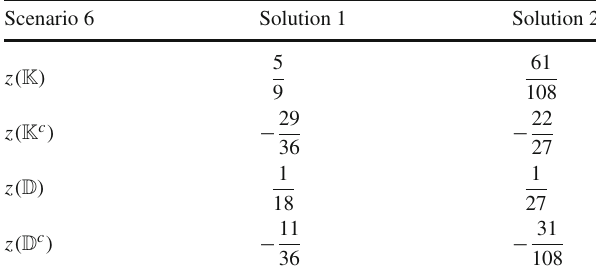
Table 28 The same as in Table 27, but for the hypercharges of Case 2 of Table 10